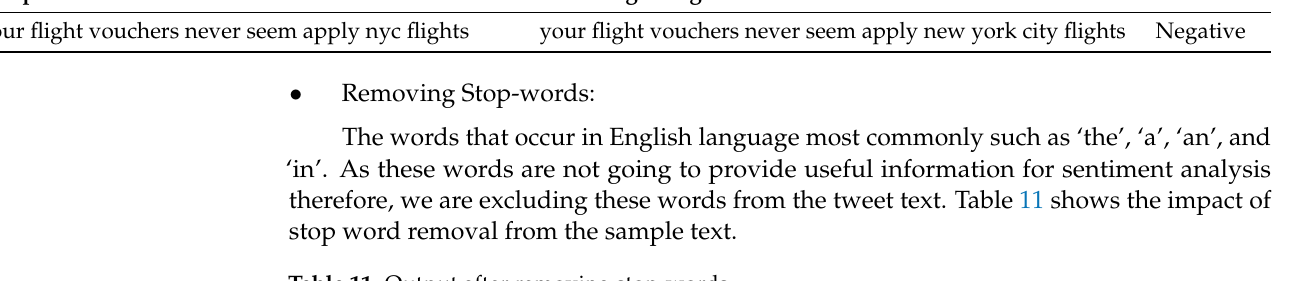
Table 11. Output after removing stop-words.